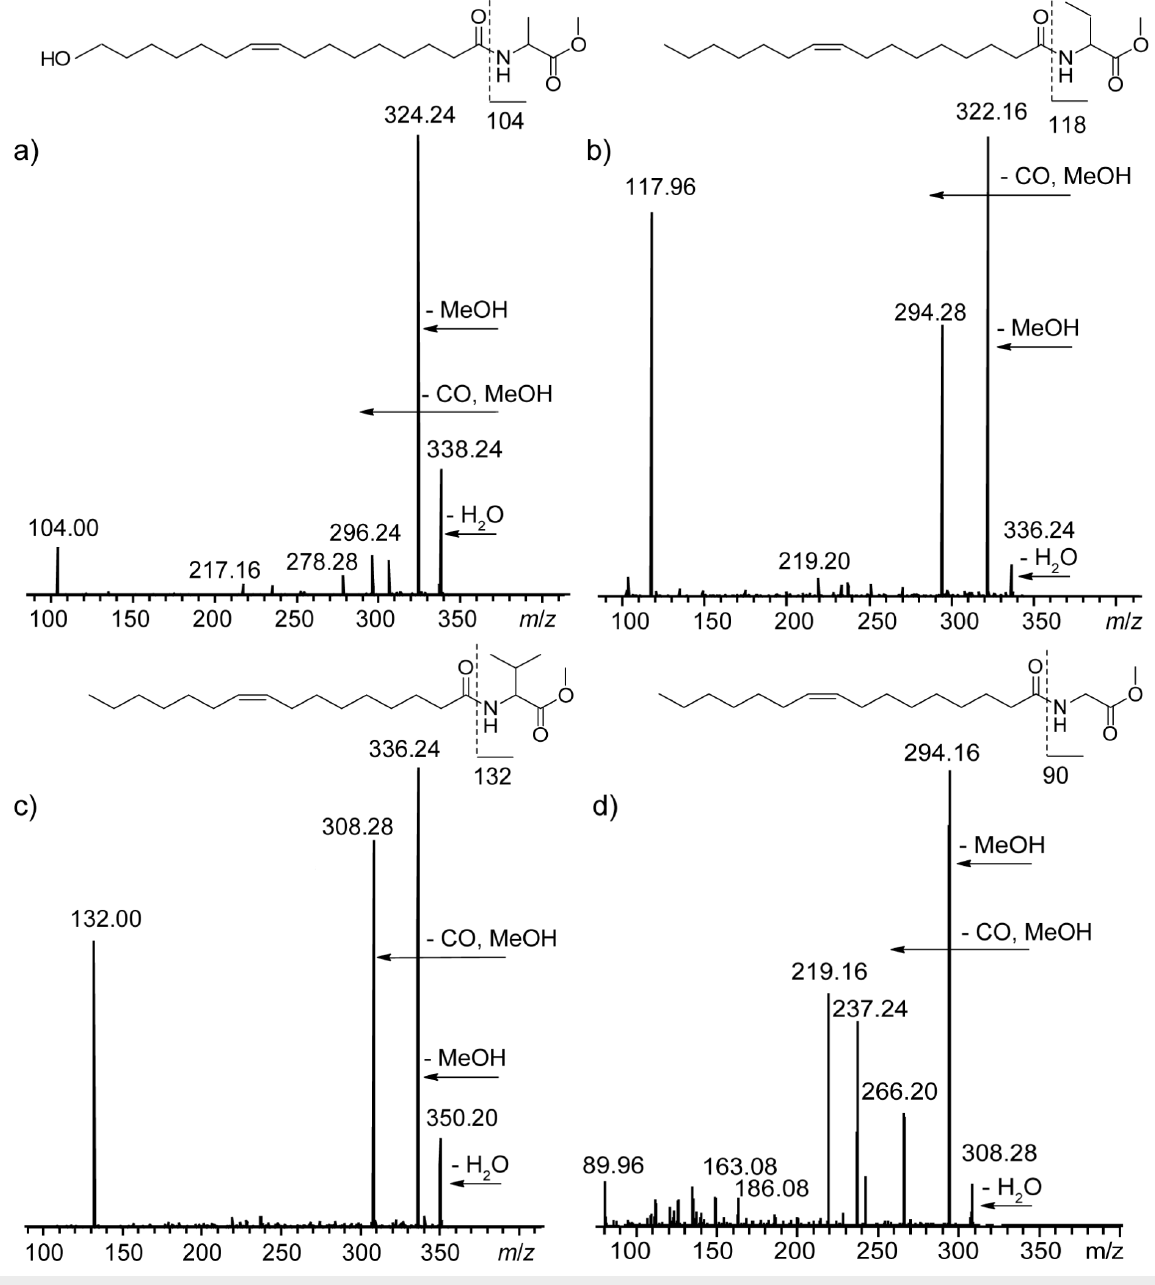
The close similarity of NAMEs, NAVMEs, and NAGMEs to AHLs might indicate a function as signalling compounds, al- though experiments with NAMEs and AHL reporter assays did not reveal any activity on the LuxR type receptors for AHLs in bacteria [23,24]. Other potential functions are antimicrobial or cytotoxic activity of the tested derivatives. Roseovarius